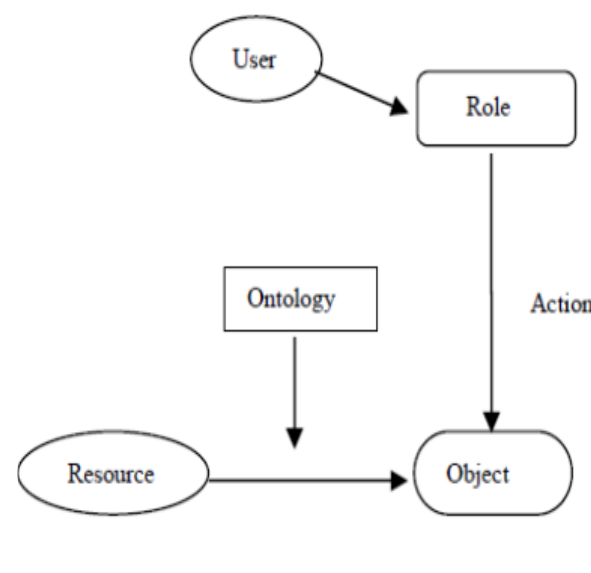
Figure 4. Semantic access control model